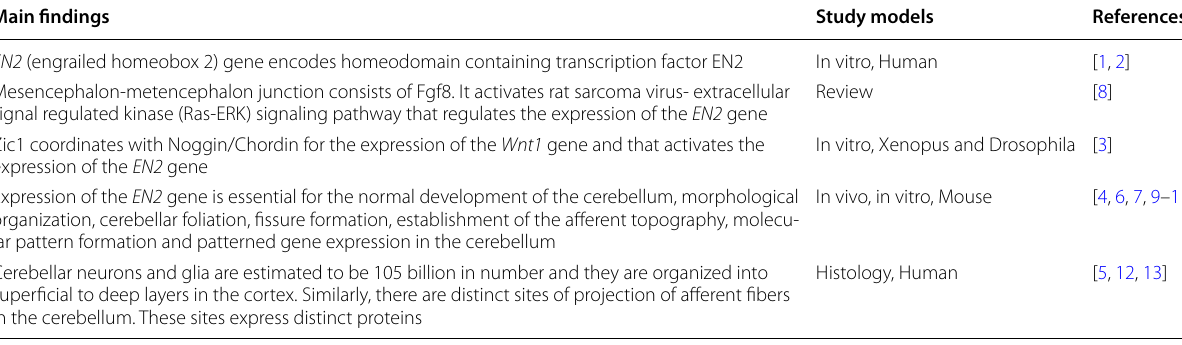
Table 1 Role of EN2 gene in the development of the cerebellum